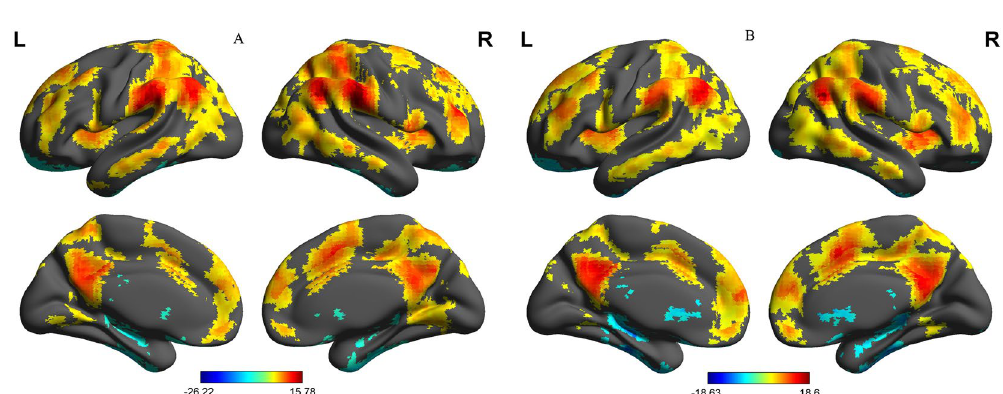
Figure 3. One sample t-test differences of PIs subjects ( A ) and GSs ( B ) in binarized degree centrality network with threshold at r = 0.25. Note: The statistical threshold was set at FDR corrected voxel threshold of p < 0.001 with a minimum voxel volume threshold of 810 mm 3 . Abbreviations: PIs, Patients with primary insomnia; GSs, Good sleepers; R, right; L, left.